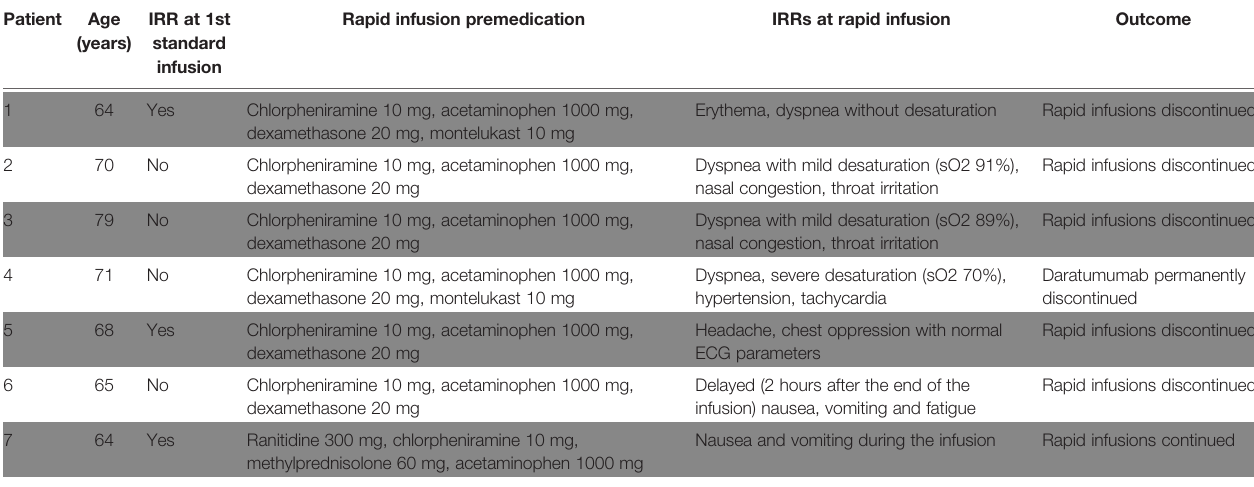
TABLE 3 | Details about patients experiencing IRRs during rapid daratumumab infusion. Patient